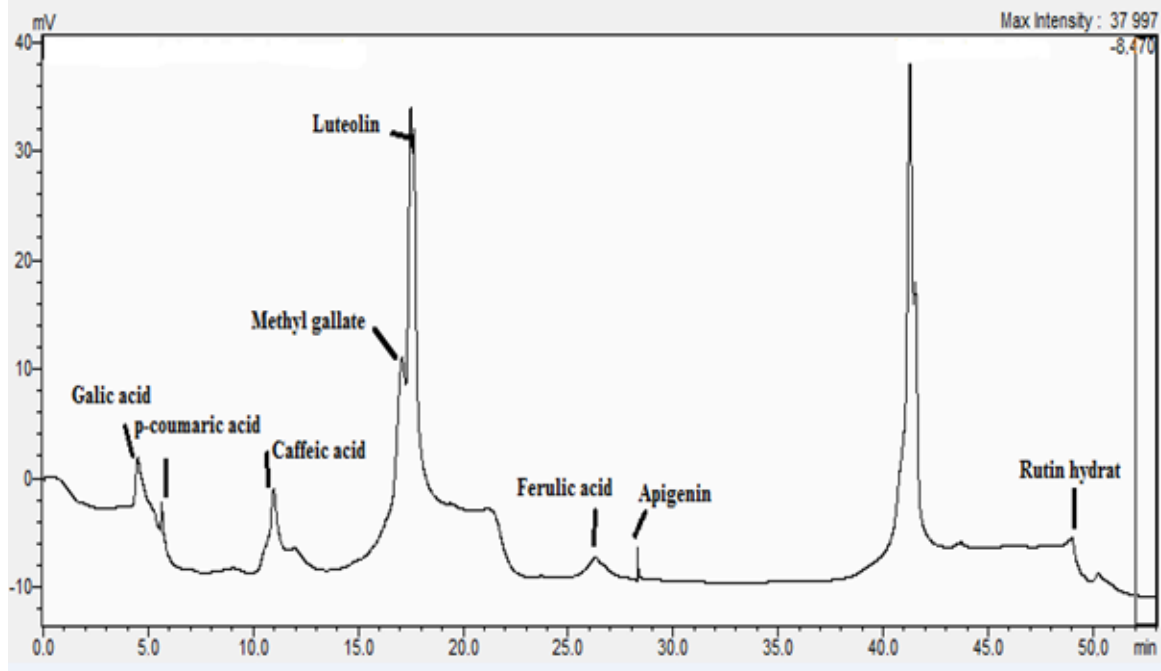
Figure 1. HPLC chromatographic profile of W. adpressa extract.